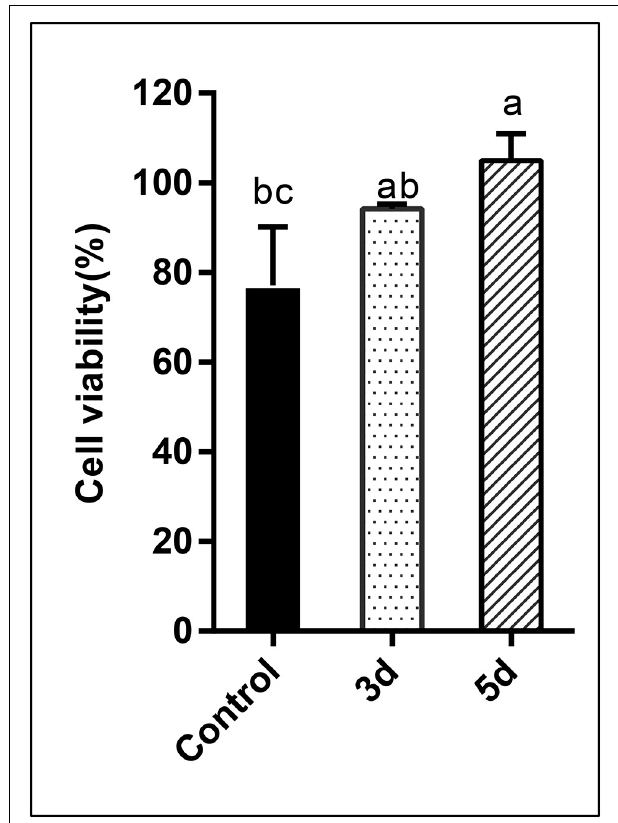
FIGURE 6 | Analysis of the cytotoxicity of AFB 1 degradation by cell-free E. cristatum culture filtrate using MTT assay. The error bars represent the standard deviations from three independent experiments with six replicates each. The same letters in each column indicate no significant differences among the data at the 5% level following the Tukey